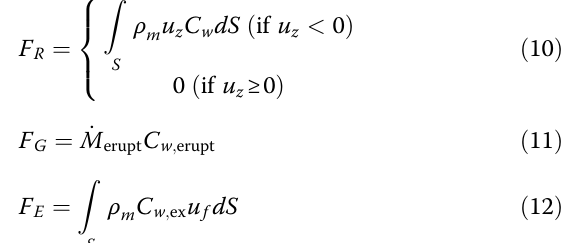
Fig. 4 Temporal variations in the mass of surface seawater with and without DHMS effects